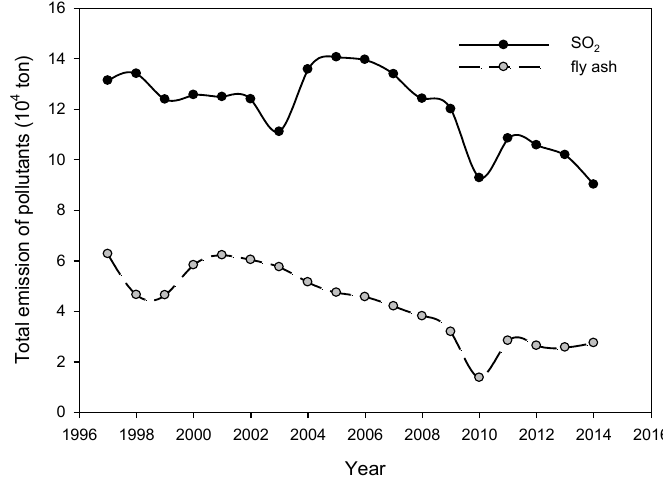
Figure 3. SO 2 and fly ash emissions in urban Wuhan.